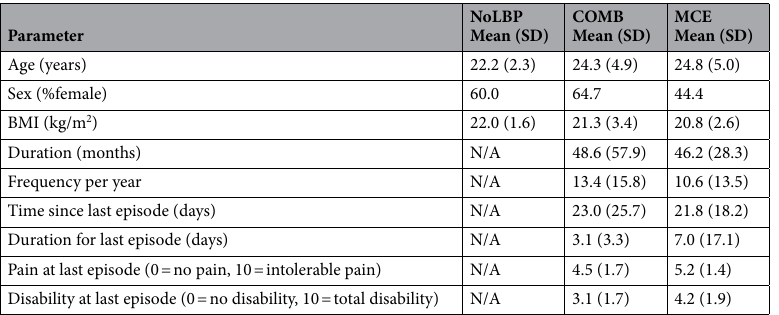
Table 1. Demographic data and LBP behavior. NoLBP = no low back pain group, COMB = combined neuromuscular electrical stimulation (NMES) with motor control exercise group, MCE = sham-NMES and motor control exercise group, BMI = body mass index.